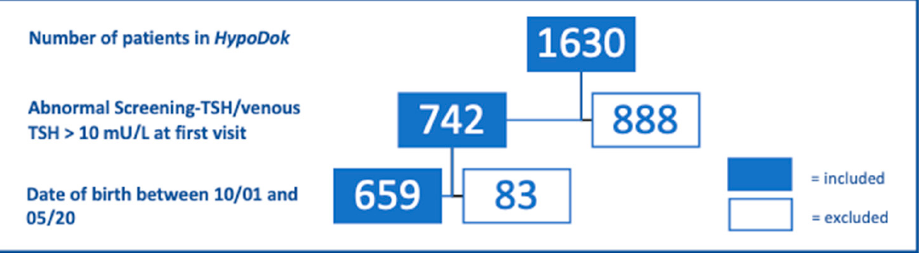
Figure 1. Eligible patients of the HypoDok registry, according to the inclusion criteria of this study (abnormal screening TSH/venous TSH > 10